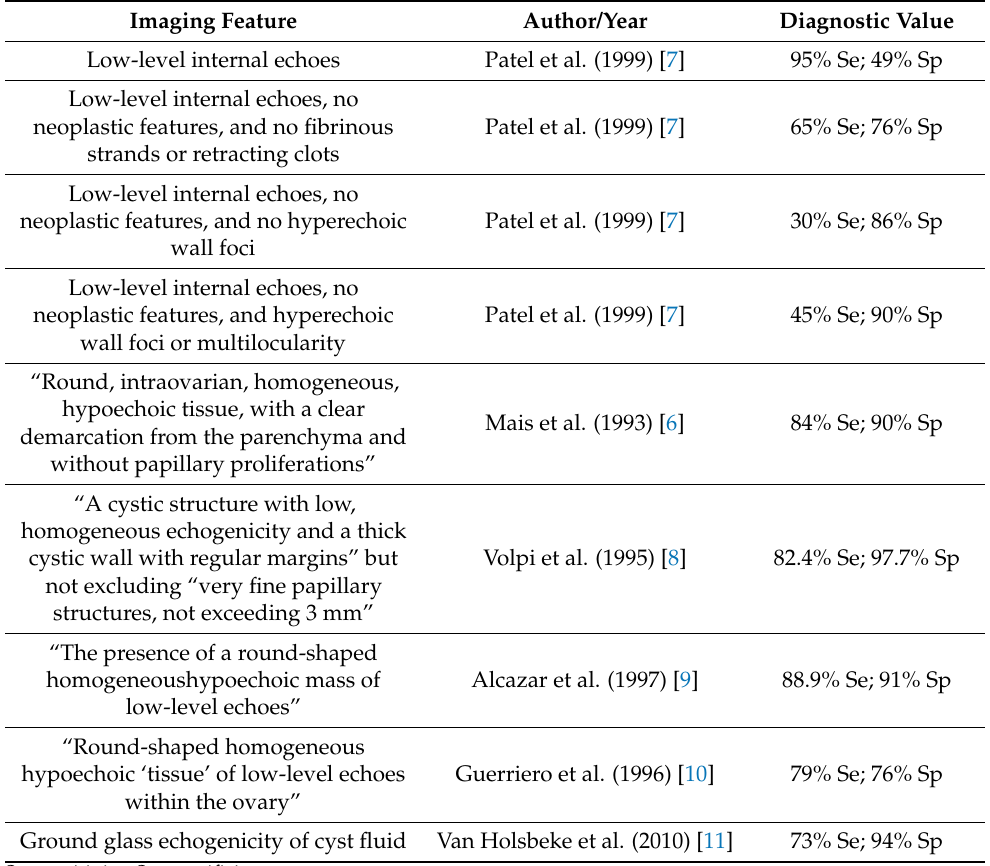
Table 7. Research involving endometriomas’ classic ultrasound